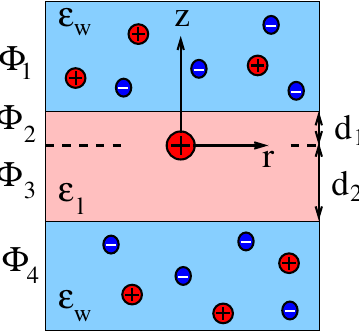
Figure A1. The origin of a cylindrical coordinate system { r , φ , z } is placed at the location of a point charge q , with distances d 1 and d 2 away from the two interfaces of the dielectric slab, which has a thickness d = d 1 + d 2 . The dielectric constant inside the dielectric slab is (cid:101) l , that inside the sandwiching media is (cid:101) w . We denote the electric potential in the region z > d 1 by Φ 1 , that in the region d 1 > z > 0 by Φ 2 , that in the region 0 > z > − d 2 by Φ 3 , and that in the region − d 2 > z > by Φ 4 . Salt is present in the two sandwiching media with bulk concentration n 0